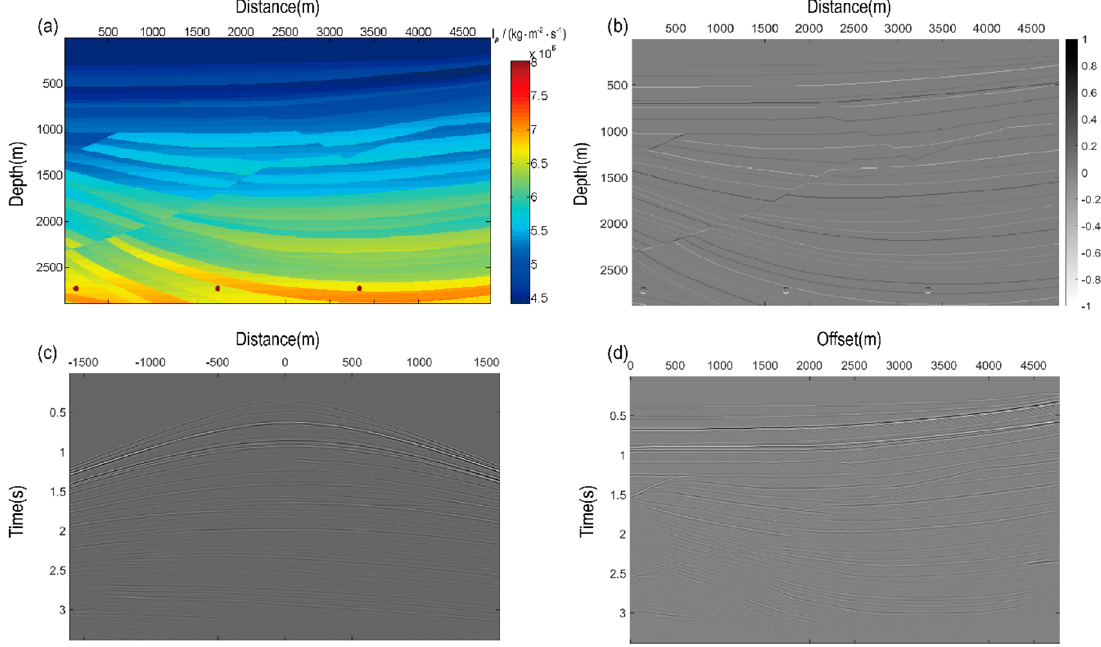
Figure 1. The true AI profile of the left part of Sigsbee2a model ( a ), where the density is assumed to be constant and equals to 2500 kg/m 3 , and the corresponding true reflectivity ( b ) is deduced by Equation (9). A sorted common shot gather located at 2880 m and the zero offset gather are shown in ( c , d ), which presents the original data for recovering the subsurface model like (a).